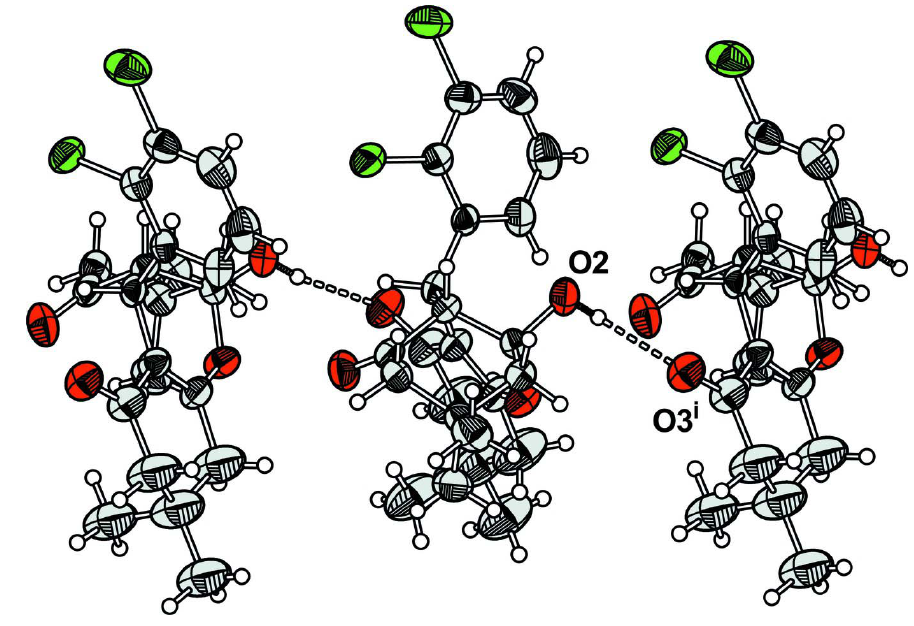
Packing view for (I), showing hydrgen